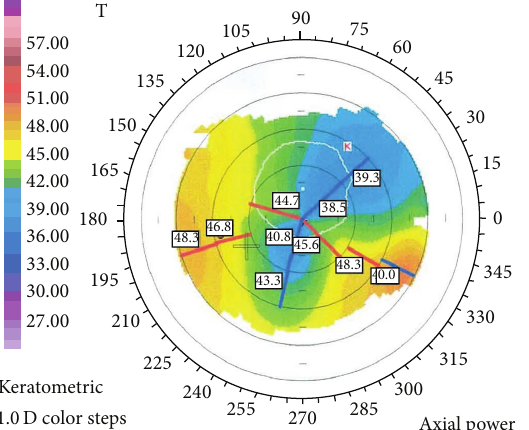
Figure 5: Orbscan photograph of right eye showing irregular astigmatism.